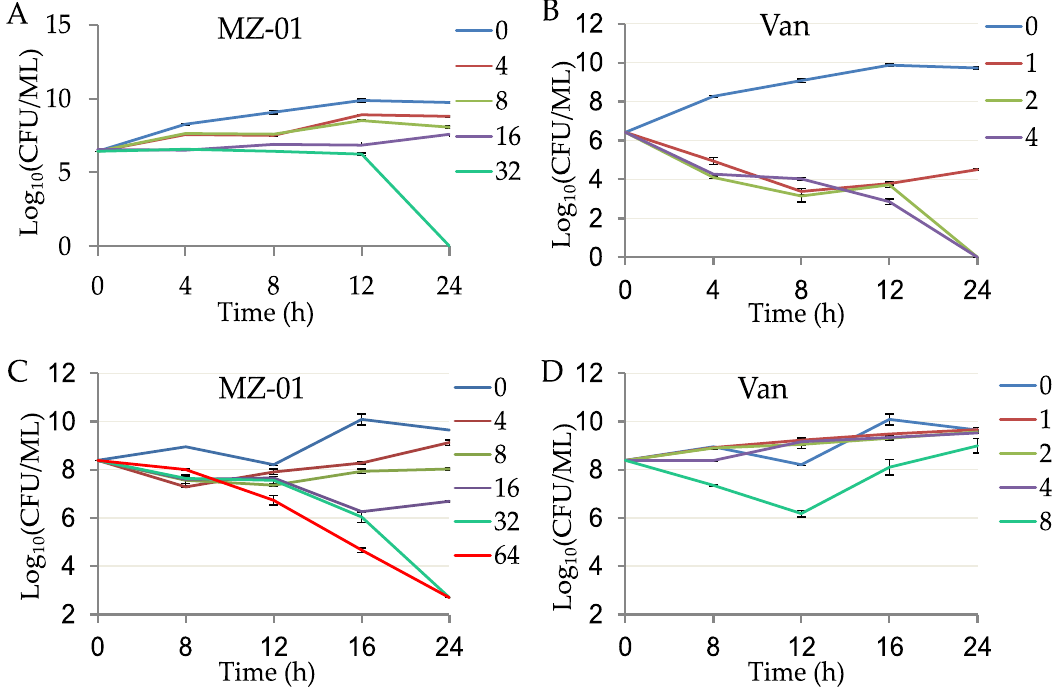
Figure 1. Time-dependent killing of MRSA by MZ-01. MRSA WCUH29 was grown in TSB to early ( A , B ) and late ( C , D ) exponential phase and were exposed to different doses of antibacterial agents. An aliquot of the culture was taken from each tube at different time points after exposing to the compounds, and a serial dilution was performed. The diluted culture was incubated at 37 ◦ C, and the average values of Log 10 CFU/mL were determined from triplicate experiments. The unit of MZ-01 and Van (vancomycin) is µ